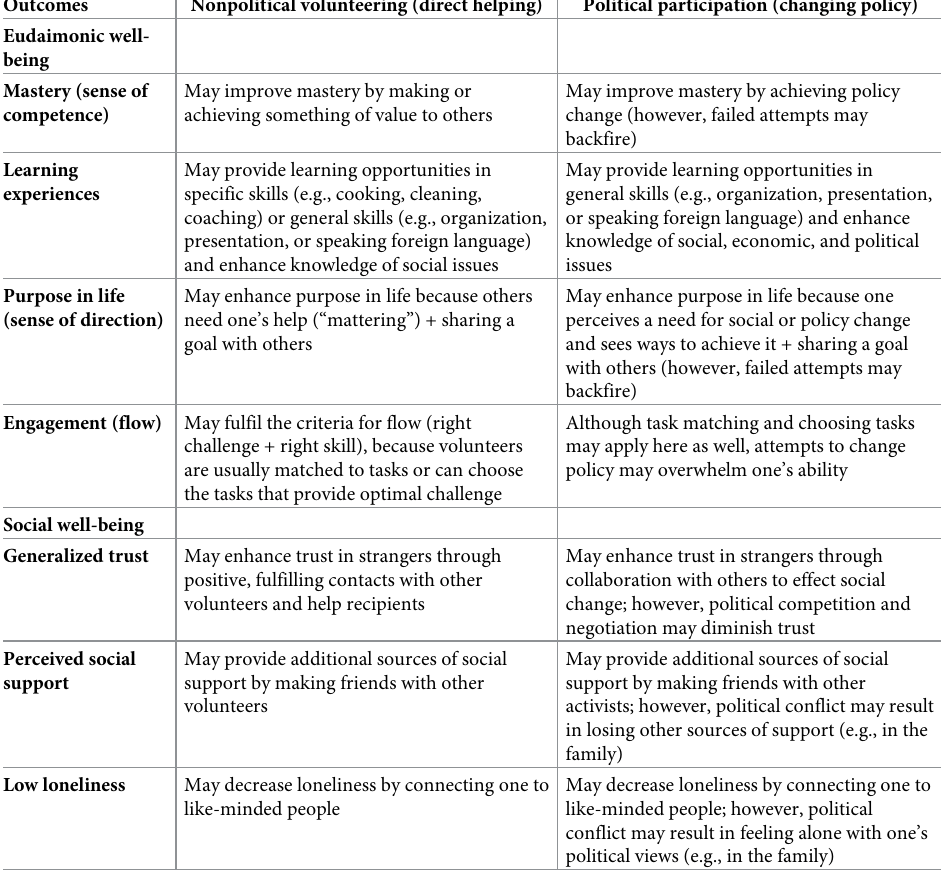
Table 1. Theoretical links between nonpolitical volunteering and political participation and the outcome variables.